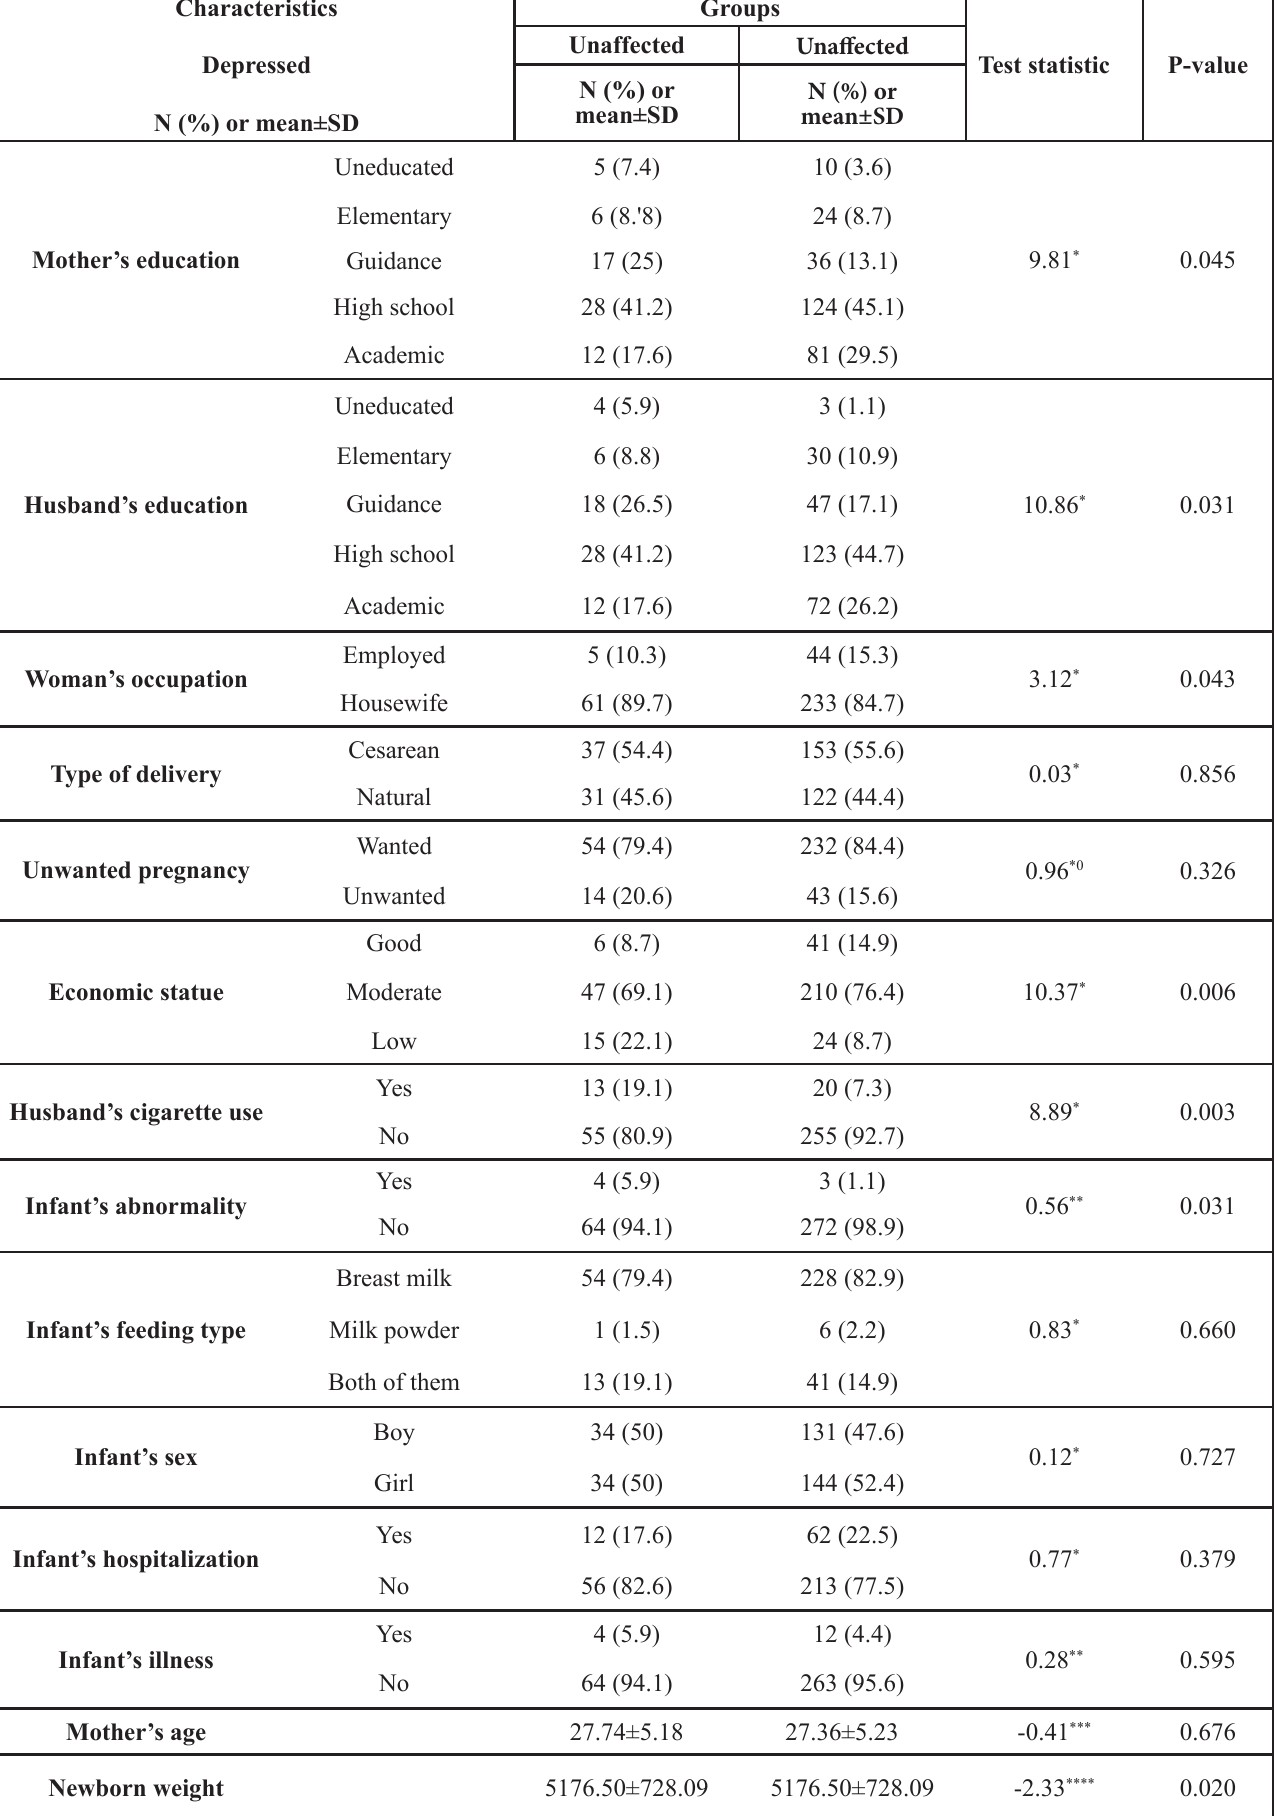
Table 1. Comparison of frequency of PD in terms of study variables in two months old Characteristics